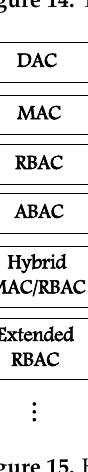
Figure 15. Heterogeneous models with different policy